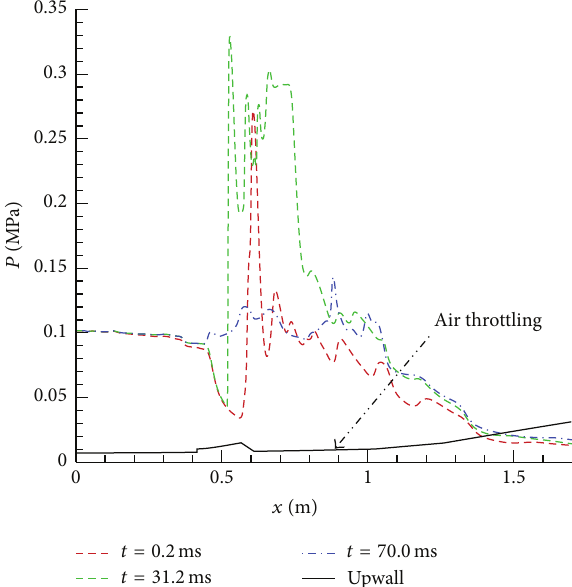
Figure 16: Wall pressure of the scramjet combustor with and without air throttling at 𝑡 = 70.0